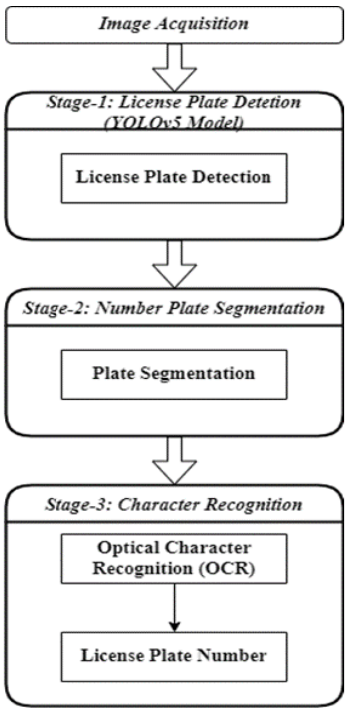
Fig. 1. Architecture of the proposed system